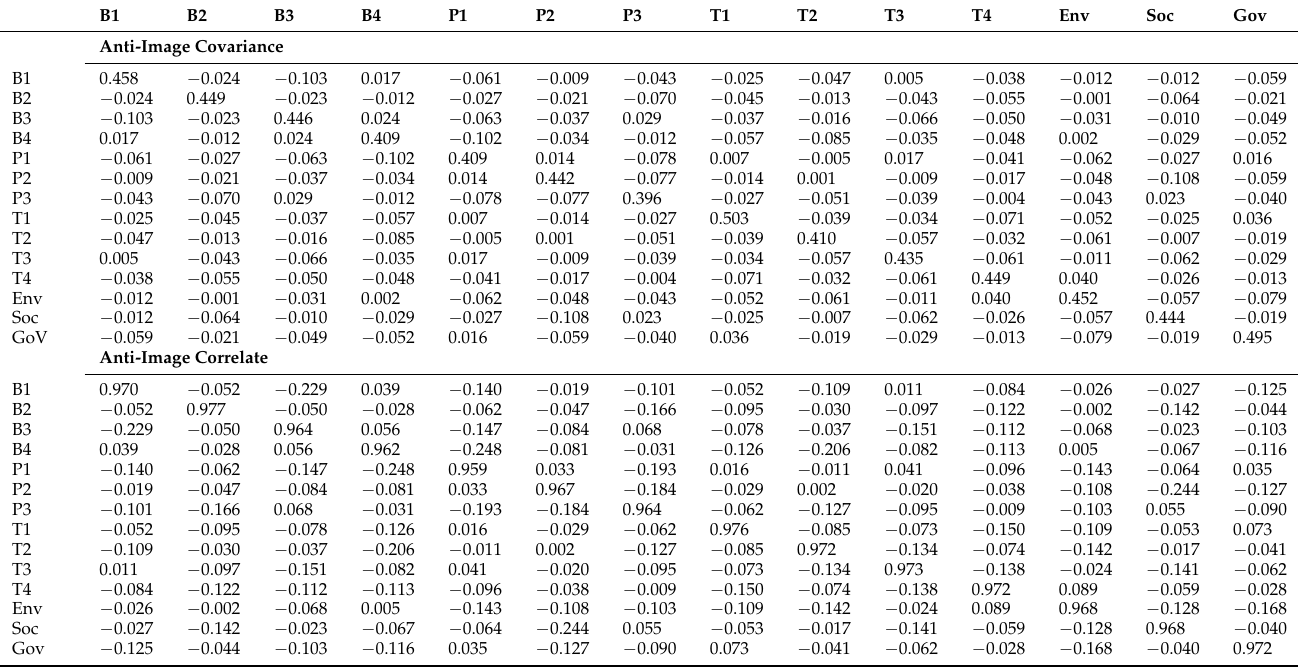
Table A5. Anti-image matrices are particularly common in factor analysis, where they are used to isolate and extract specific components or factors from complex